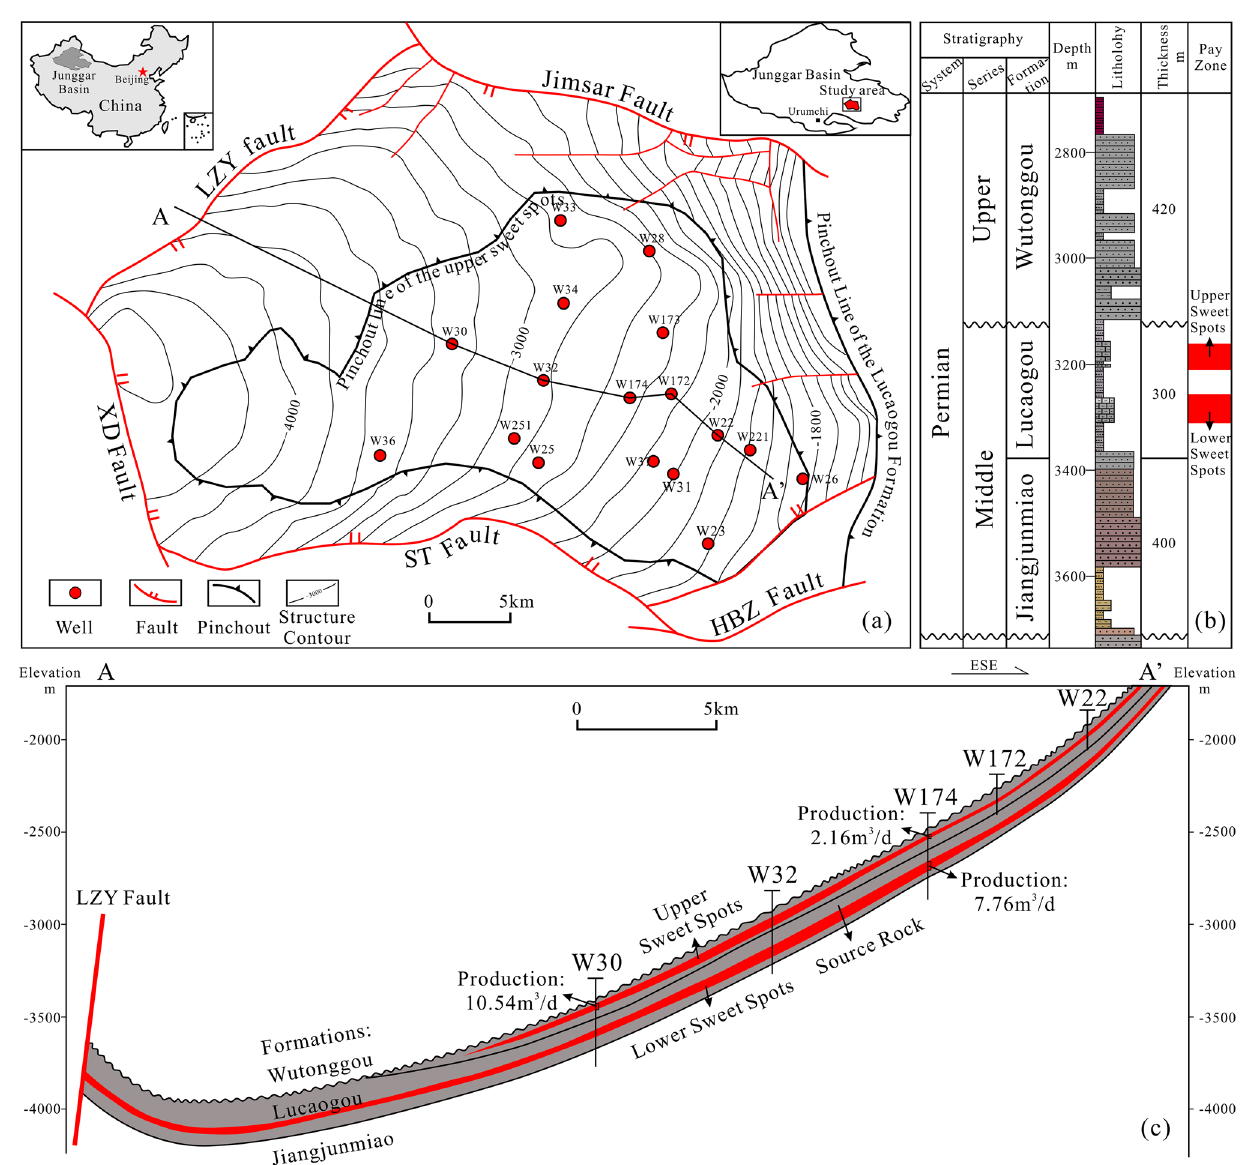
Fig. 3 a Lucaogou Formation top structure map, b stratigraphy column of Middle and Upper Permian, main tight oil exploration target is Luca- ogou formation, c well section from west to